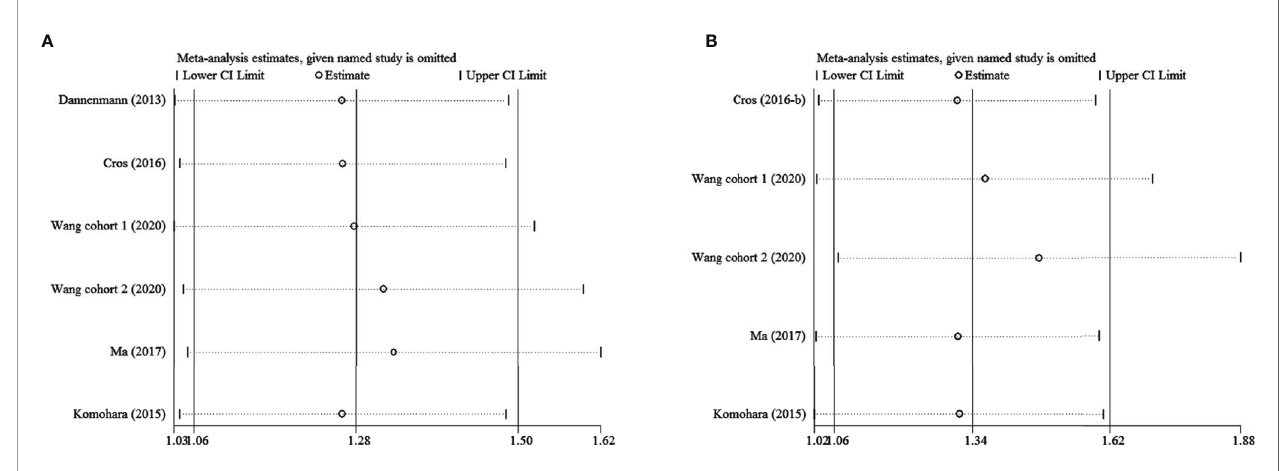
FIGURE 5 | Sensitivity analysis. (A) M2-TAMs and OS; (B) M2-TAMs